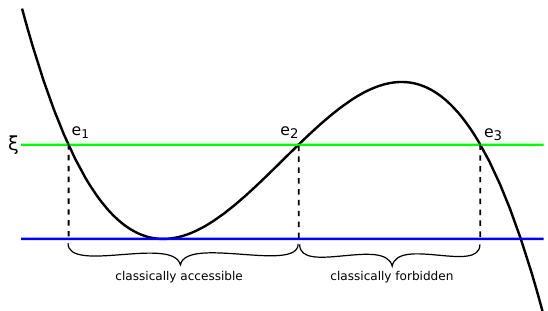
Figure 2 . The classically accessible and forbidden regions of a cubic